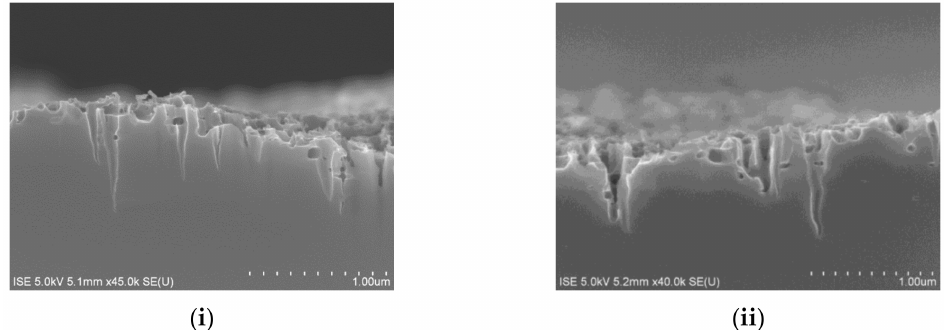
Figure 9. Cross-sectional SEM images showing possibilities of anisotropic etching at ( i ) T wafer = 250 ◦ C ( σ F = 3.33%, v = 5 mm / s) and ( ii ) T wafer = 300 ◦ C ( σ F = 5%, v = 8 mm / s). Both surfaces show an identical R w ≈ 11%. The etch rates are measured to be 0.9 µ m / min and 2.3 µ m / min at T wafer = 250 ◦ C and T wafer = 300 ◦ C